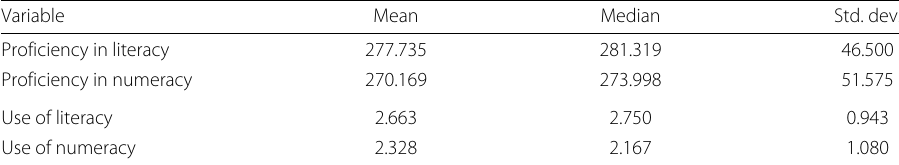
Table 2 Proficiency and use of literacy and numeracy Variable